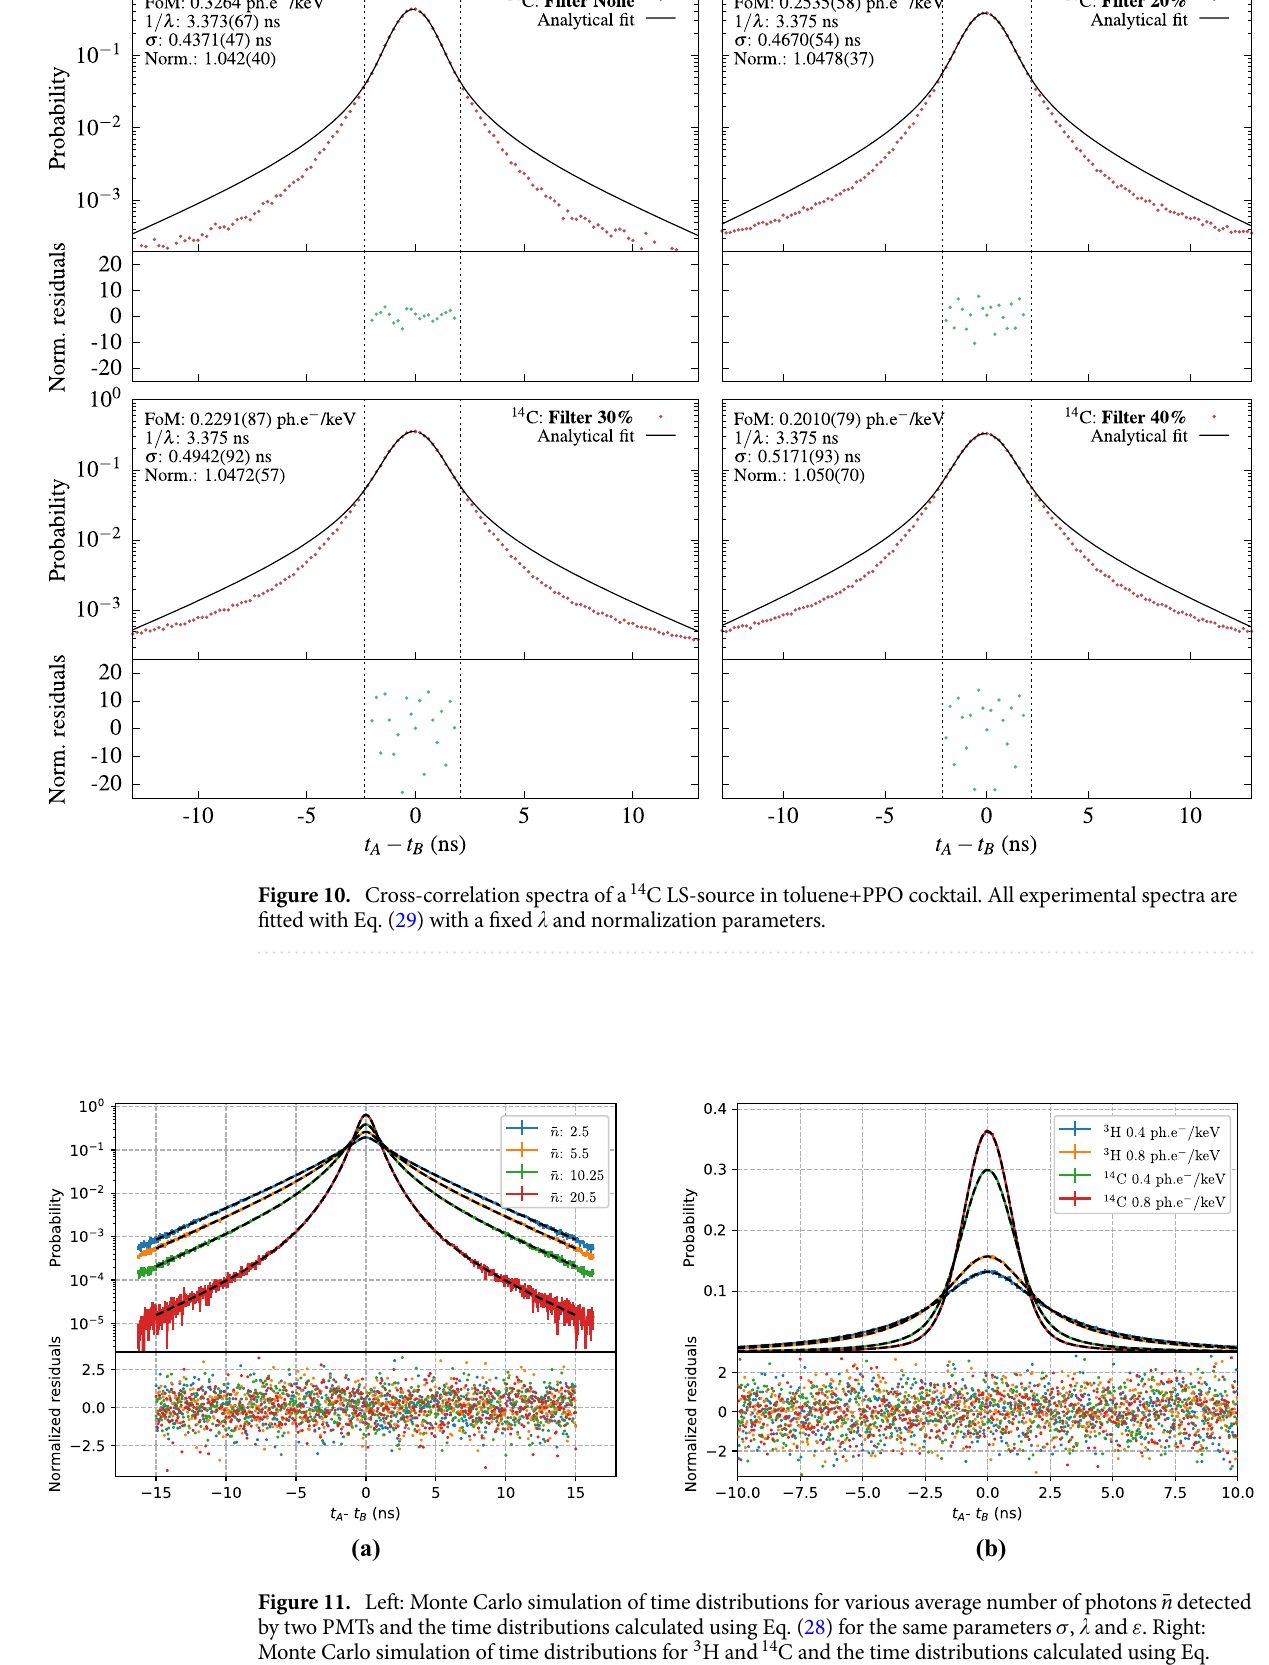
3 14 H and C and the time distributions calculated using Eq.